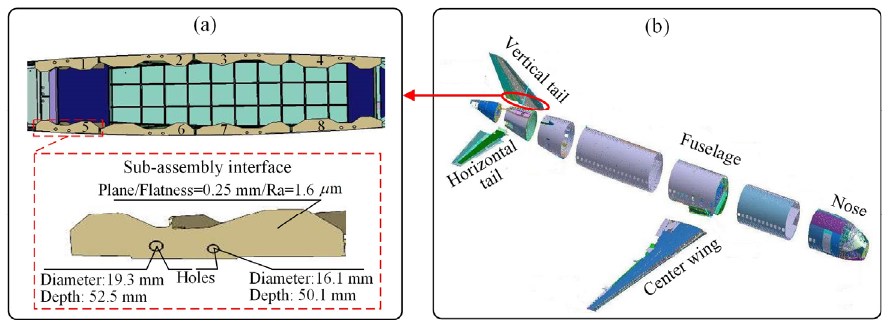
Figure 1. The assembly interfaces of an aircraft vertical tail: ( a ) Assembly interfaces; ( b ) large aircraft. Surface roughness is typically monitored either offline or online. The offline ap-